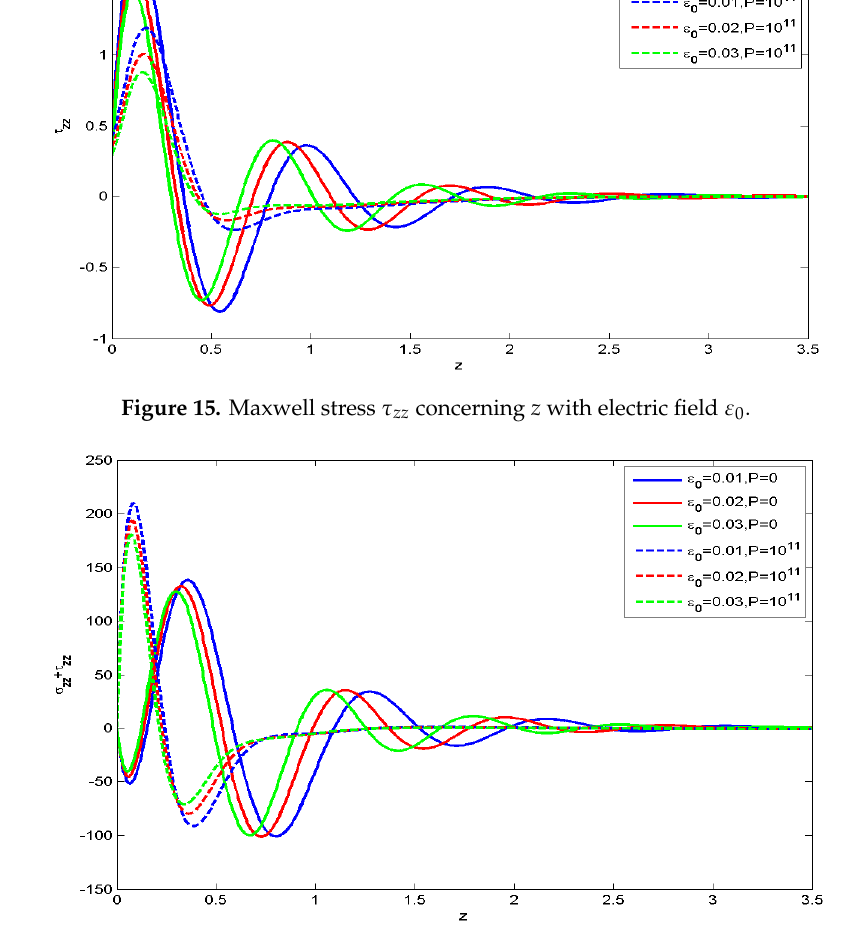
Figure 16. Total stresses τ zz + σ zz concerning z with electric field ε 0